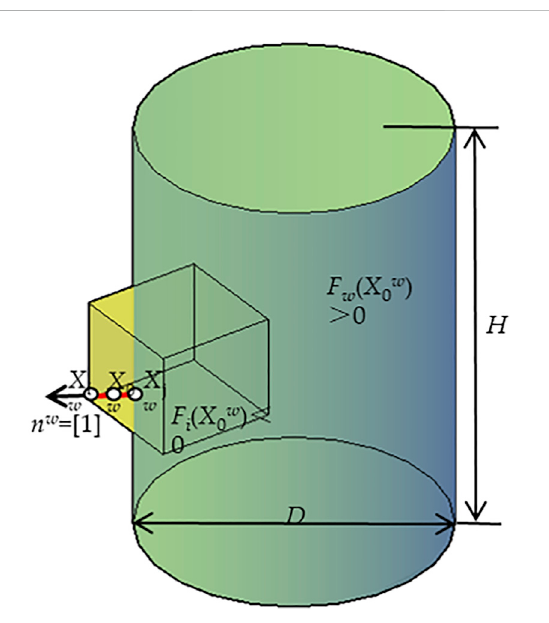
FIGURE 4 Schematicdiagramofcontactdetectionbetweenthesurface